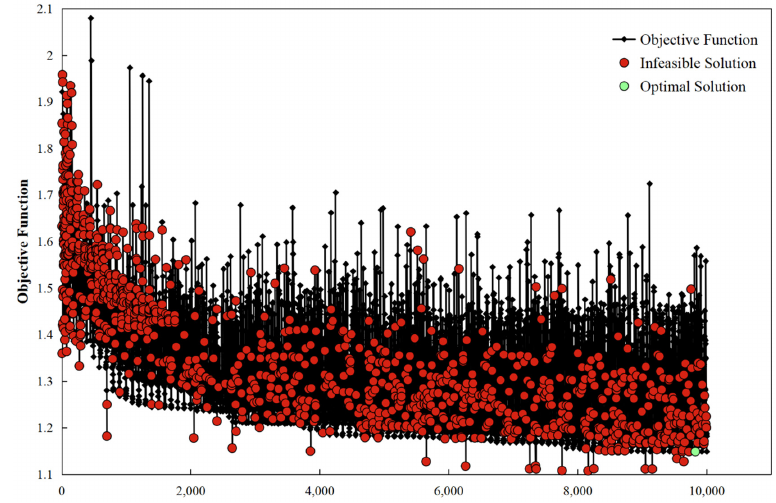
Figure 13. Change curve of the objective function with the number of iterations.